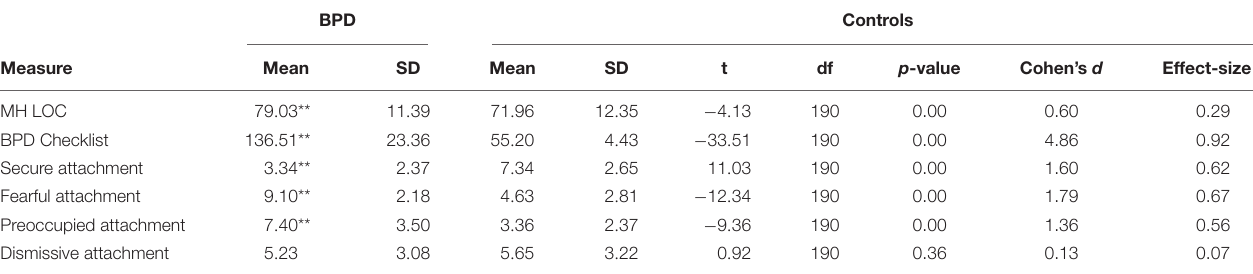
TABLE 2 | Means, standard deviations, and T -test for variables in BPD ( N = 96) and Control Sample ( N = 96). BPD